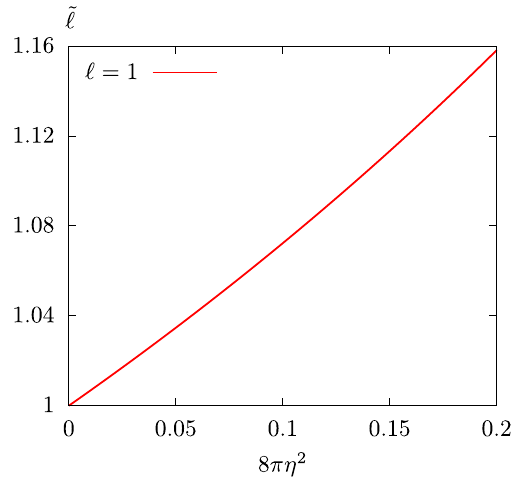
Fig. 4 Variation of ˜ (cid:2) with respect to the monopole parameter 8 πη 2 , by taking (cid:2) = 1 as an example. It shows clearly that ˜ (cid:2) increases as the monopole parameter 8 πη 2